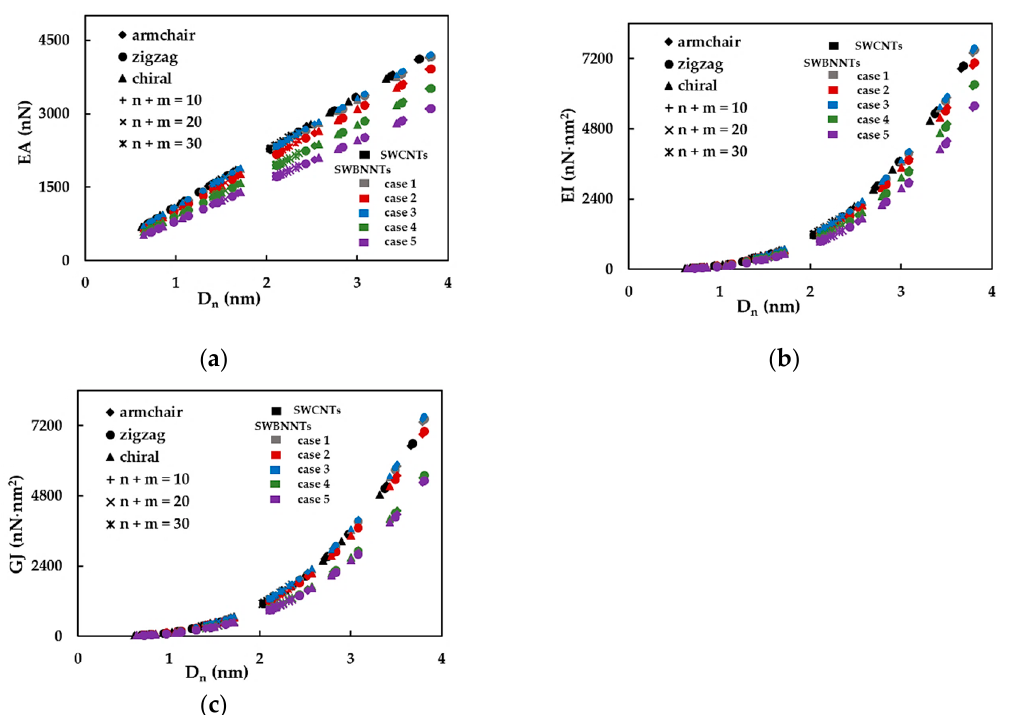
Figure 3. The evolution of rigidity as a function of the nanotube diameter, D n , for non-chiral and chiral SWBNNTs considering five different cases of input parameters and for SWCNTs with the same chiral indices in: ( a ) tension, EA, ( b ) bending, EI, and ( c ) torsion, GJ. See also Table 3.